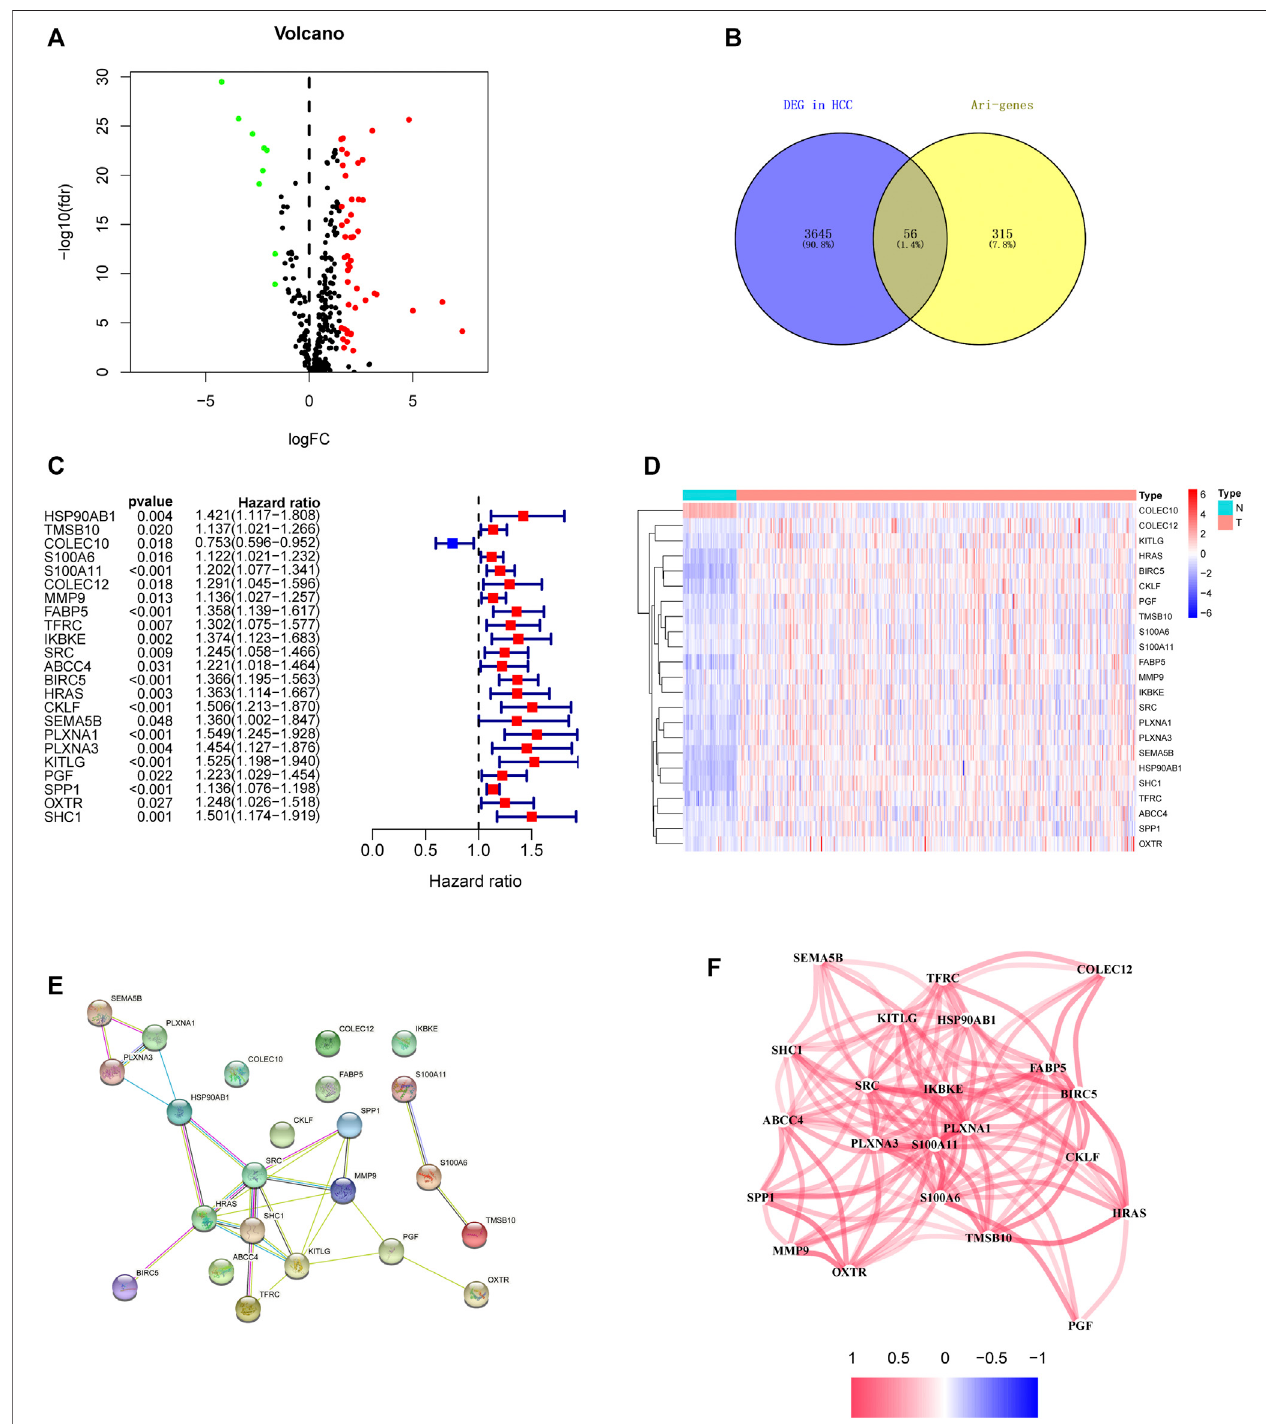
FIGURE 3 | Identi fi cation of the candidate angiogenesis-related immune genes in the TCGA discovery cohort. (A) Heatmap of DEari-genes between tumor and normaltissues.Redcolorrepresentsup-regulation ofgenes,and green colorrepresents down-regulation ofgenes. (B) Volcanoplot ofDEari-genesbetweentumor and normal tissues. (C) Forest plots showing OS-related ari-genes via univariate Cox regression. (D) Heatmap of OS-related ari-genes. (E) PPI network indicating the interactions among these candidate genes. (F) Network showing the correlation of candidate genes.